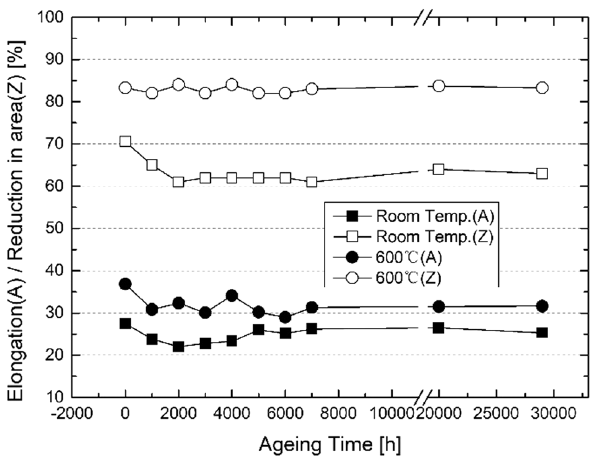
Figure 8: The elongation and reduction in area during di ff erent aging